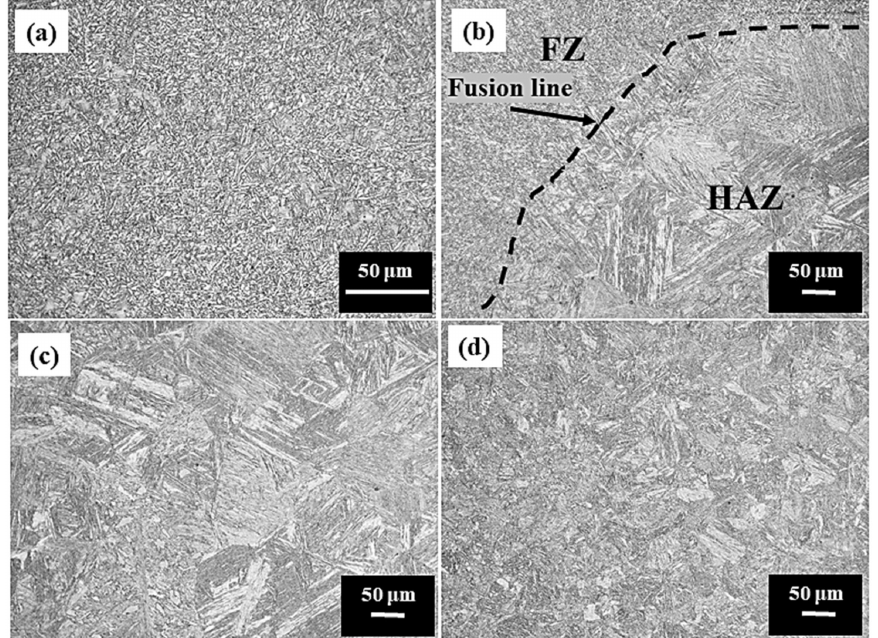
Figure 5. Different microstructures of the welding zones: ( a ) FZ, ( b ) transition of the FZ to the HAZ (fusion line can be observed), ( c ) HT-HAZ and ( d )